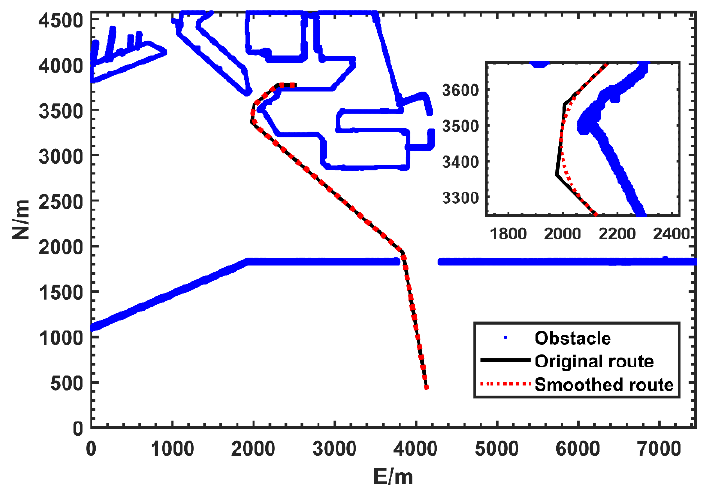
Figure 7. The effect of G2CBS path-smoothing algorithm.